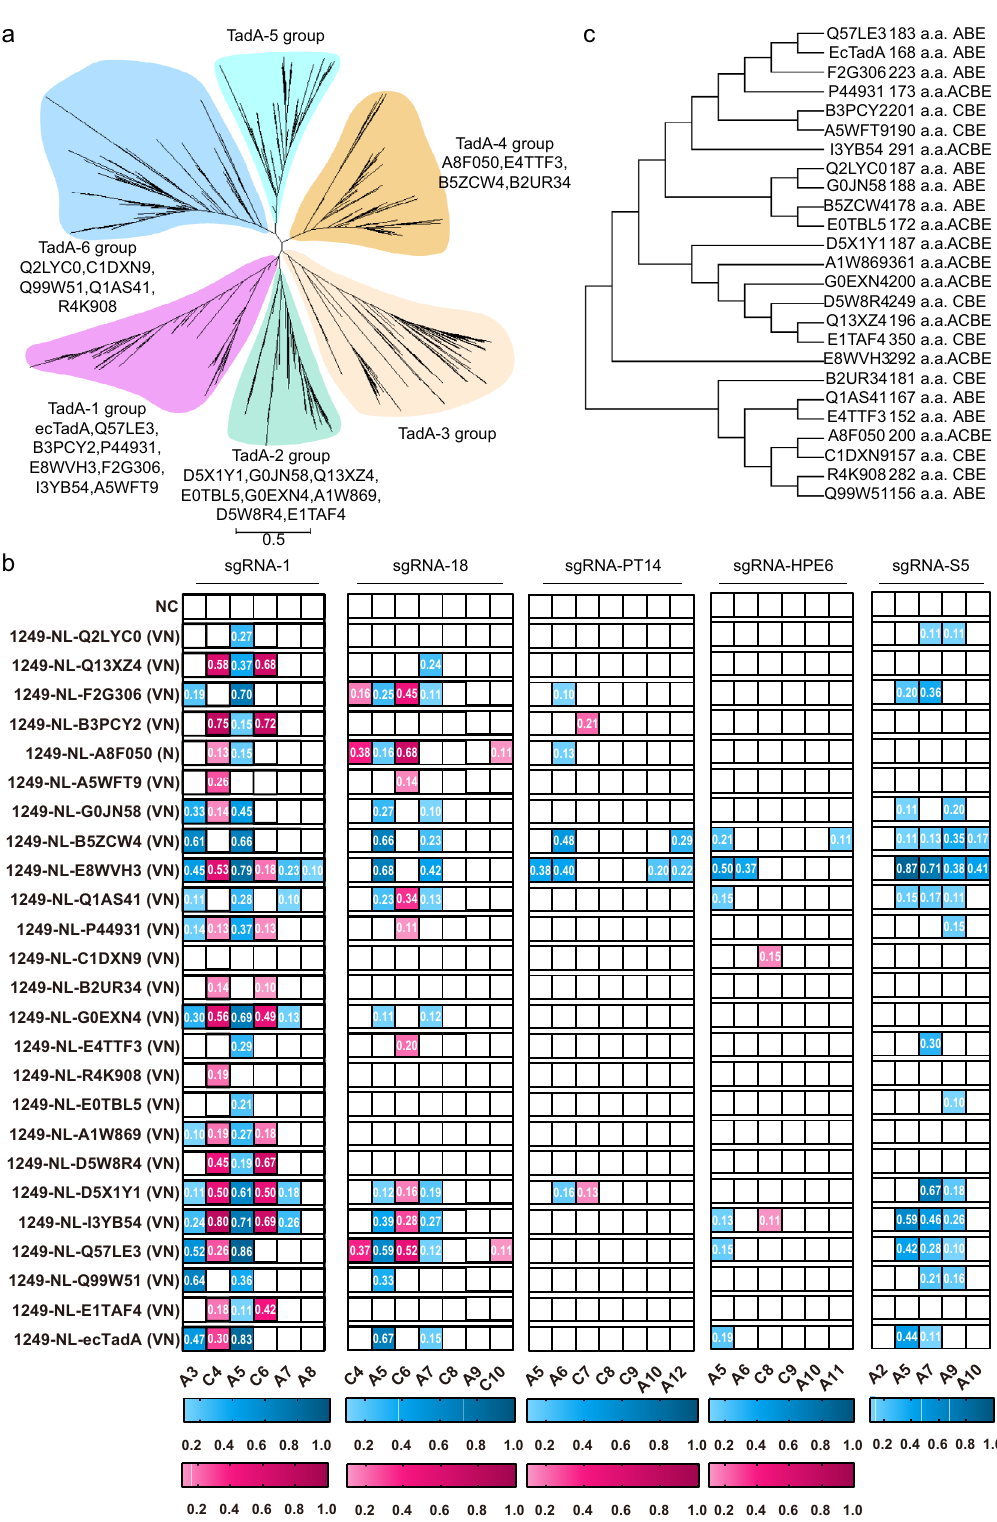
represent means of results from n =2 biologically independent experiments. c Phylogenetic tree showing the relationship between 25 functional TadA ortho- logs. Protein lengths and substrate speci fi cities of derived base editors were pre- sented simultaneously. NC negative control. VN, amino acid substitutions corresponding to A106V&D108N of ecTadA. Source data are provided as a Source Data fi